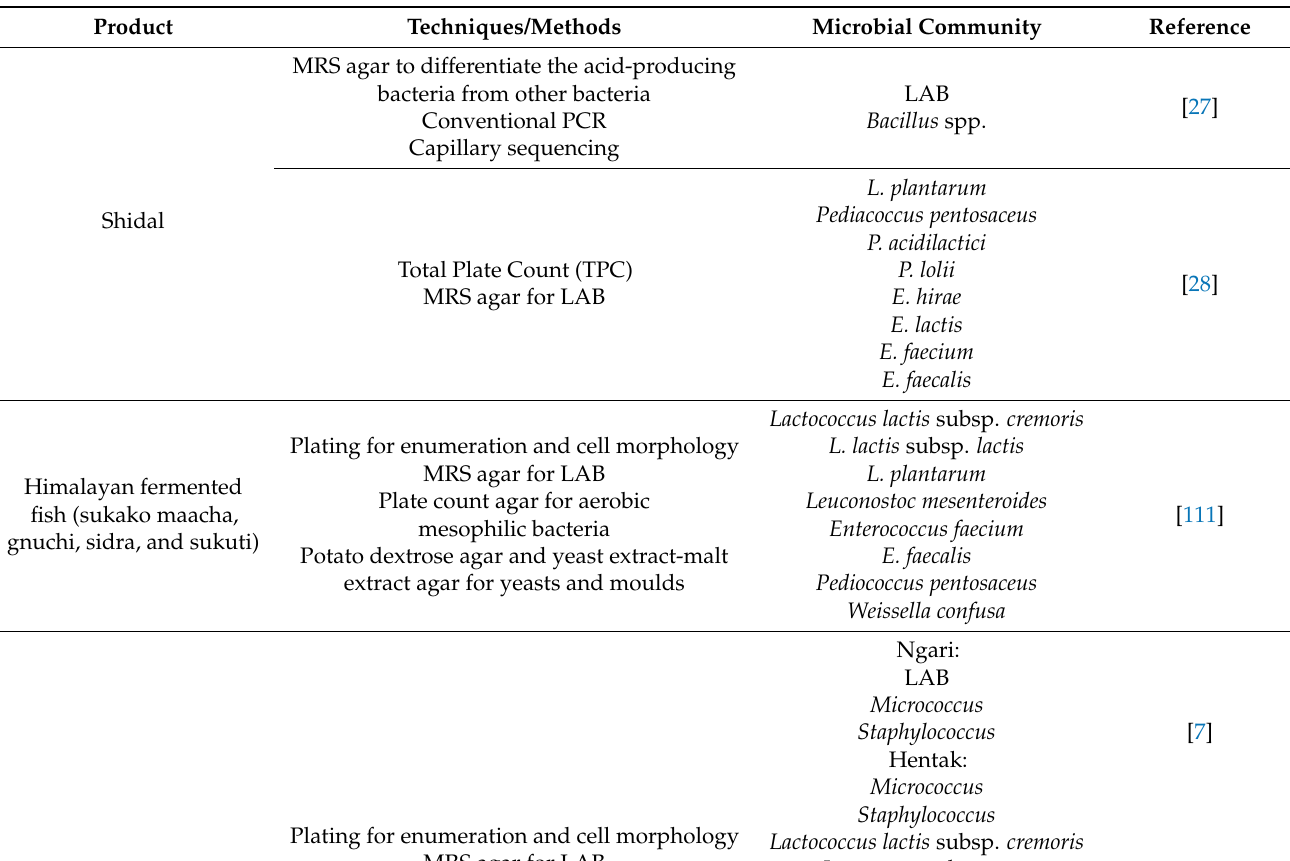
Table 3. Microbial diversity of various fermented fish